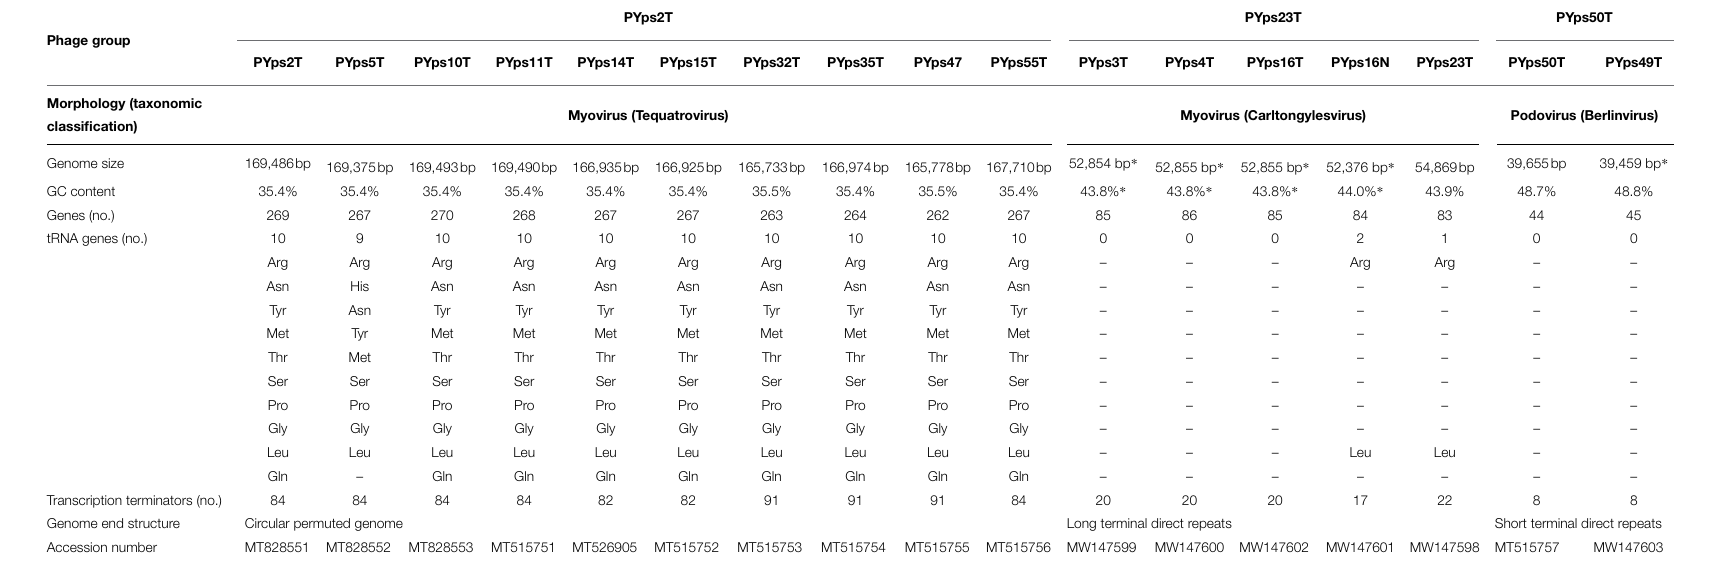
TABLE 4 | Morphological and genomic properties of the isolated Y. pseudotuberculosis phages.